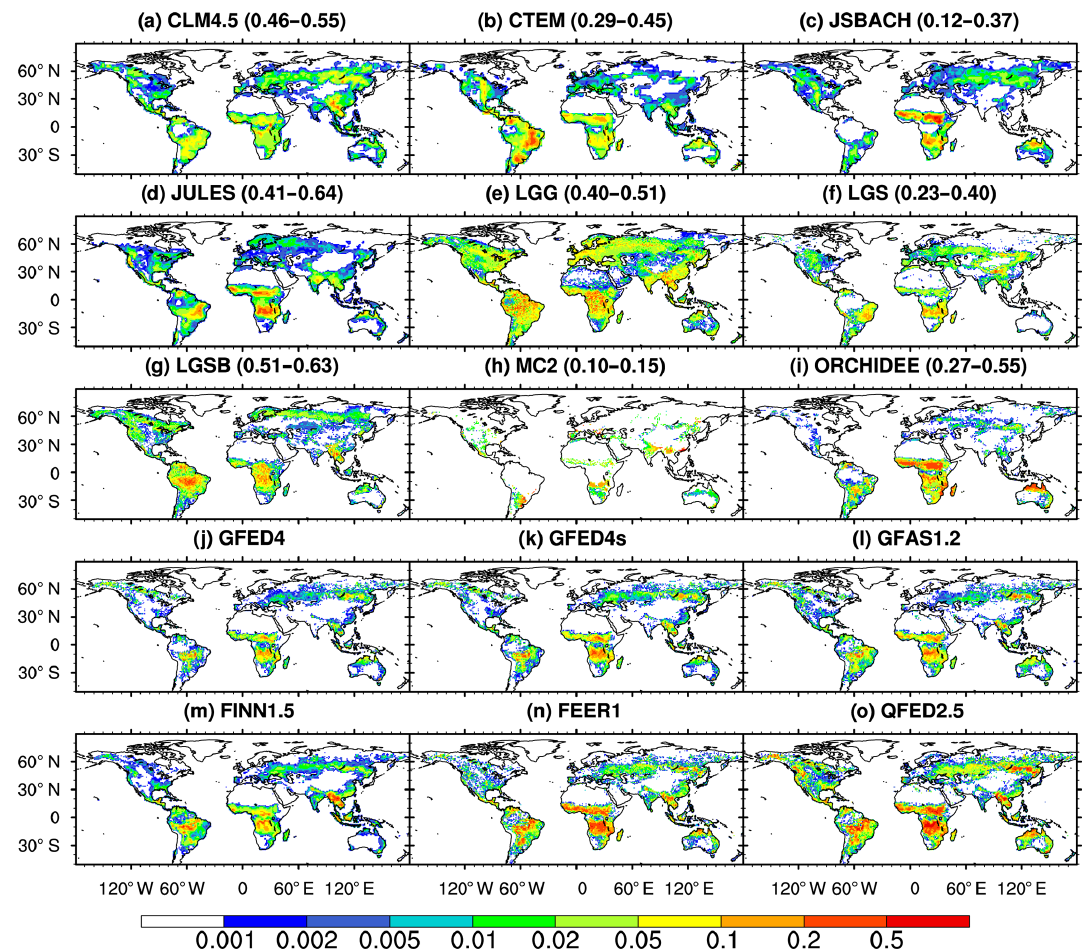
Figure 2. Spatial distribution of annual fire black carbon (BC) emissions (gBCm − 2 yr − 1 ) averaged over 2003–2008. The range of global spatial correlation between DGVMs and satellite-based products is also given in